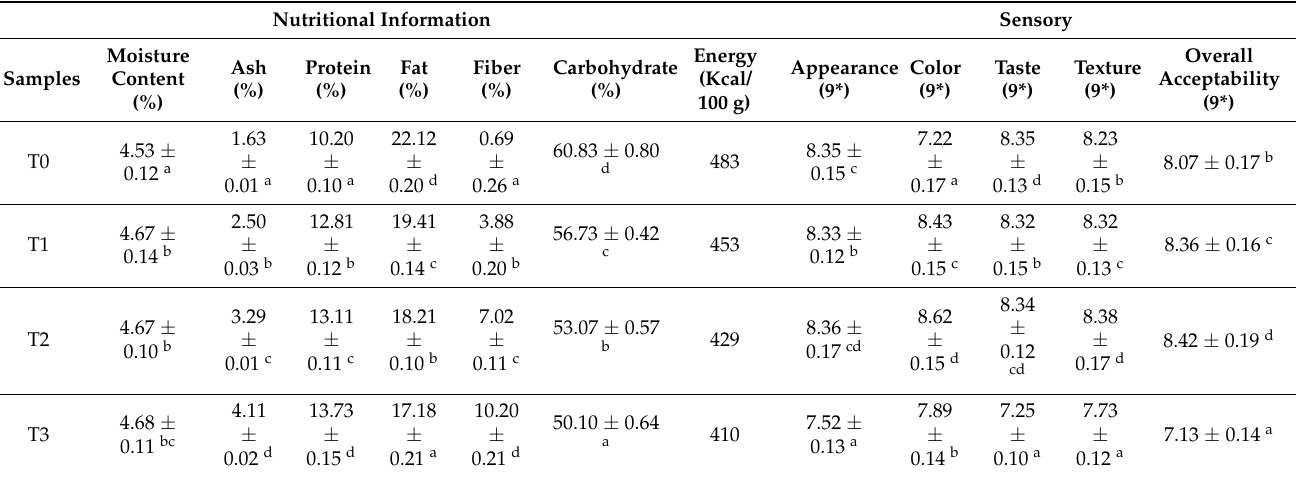
Table 5. Nutritional and sensory analyses of gluten-free biscuits fortified with different levels of date pit flour (DPF) and Assyrian plum flour